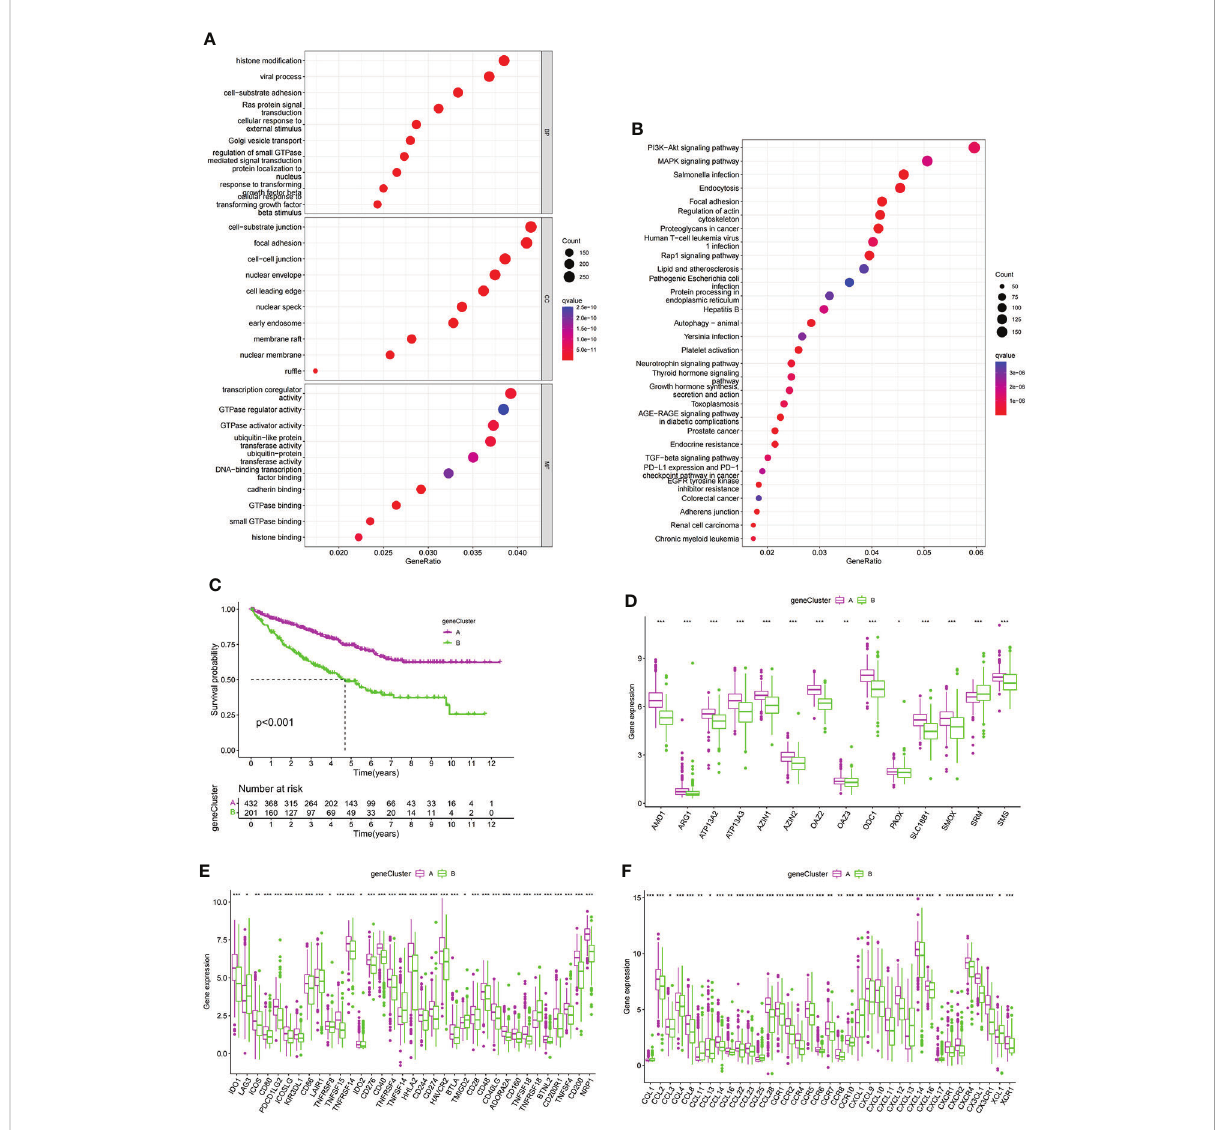
FIGURE 3 Development of gene cluster. (A, B) GO and KEGG analyses of DEGs. (C) K – M curve of survival difference of gene clusters. (D) Expression levels of PMRGs among different gene clusters. (E) Differences in immune checkpoint expression among gene clusters. (F) Differences in chemokine expression among gene clusters. PM, polyamine metabolism; PMRGs, polyamine metabolism-related genes. *p < 0.05, **p < 0.01, ***p <